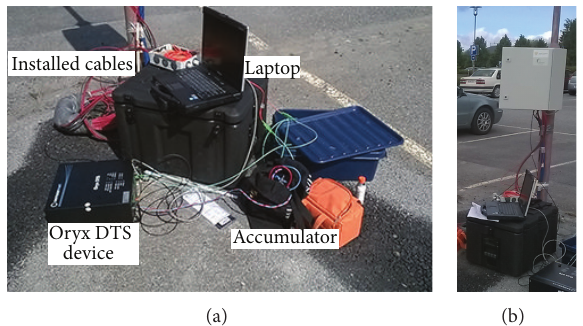
Figure 6: (a) Set-up for asphalt temperature measurement. (b) Measurement